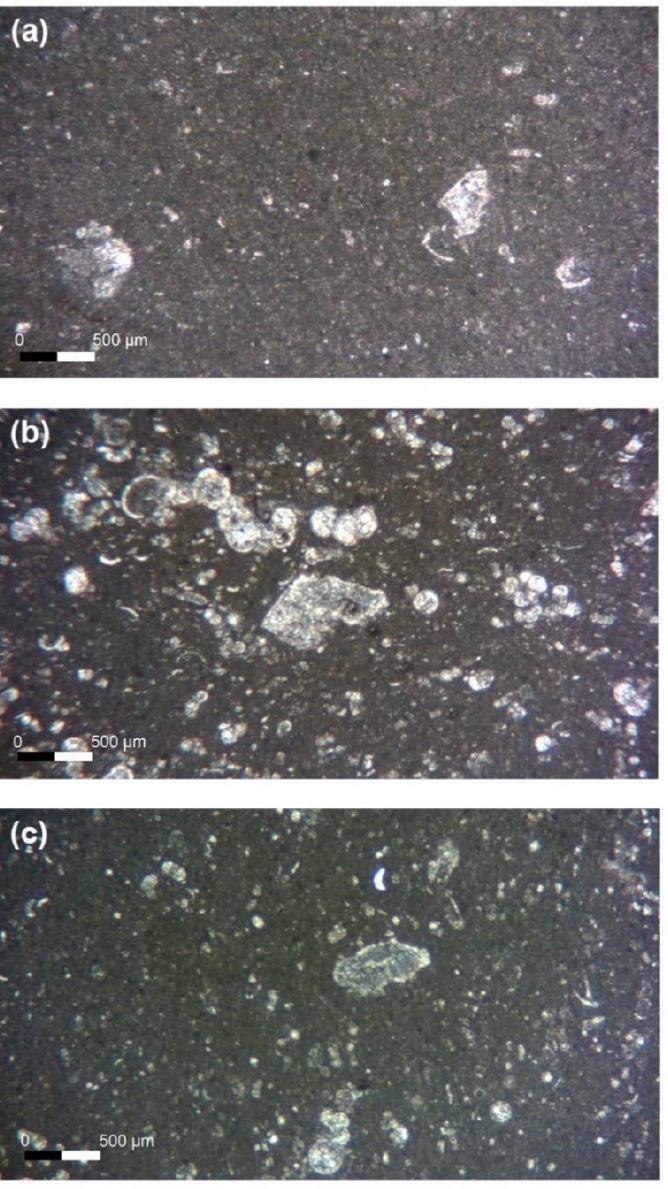
Figure 7. Main microfacies types recognized: ( a ) Pelagic biomicrite mudstone with planktonic foraminifera, radiolarians, and filaments, ( b ) Pelagic wackestone–packstone with in situ planktonic foraminifera, ( c ) Pelagic biomicrite wackestone with altered planktonic foraminifera and/or radio- larians.